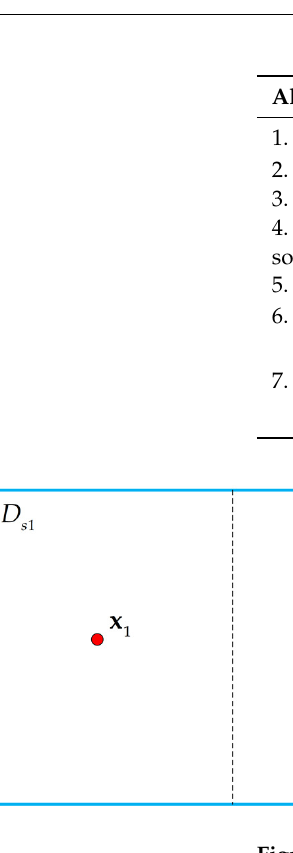
Figure 7. Diagram of the binary branching strategy.